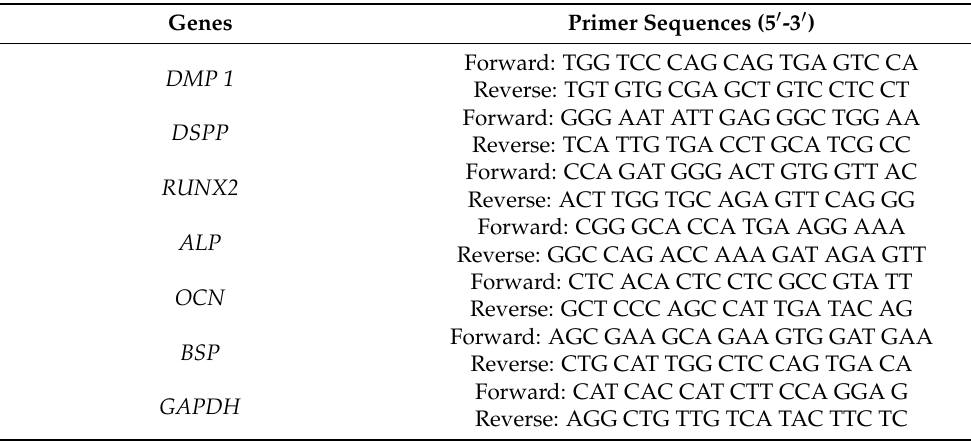
Table 1. List of Primer Sequences included in this study for real-time PCR.